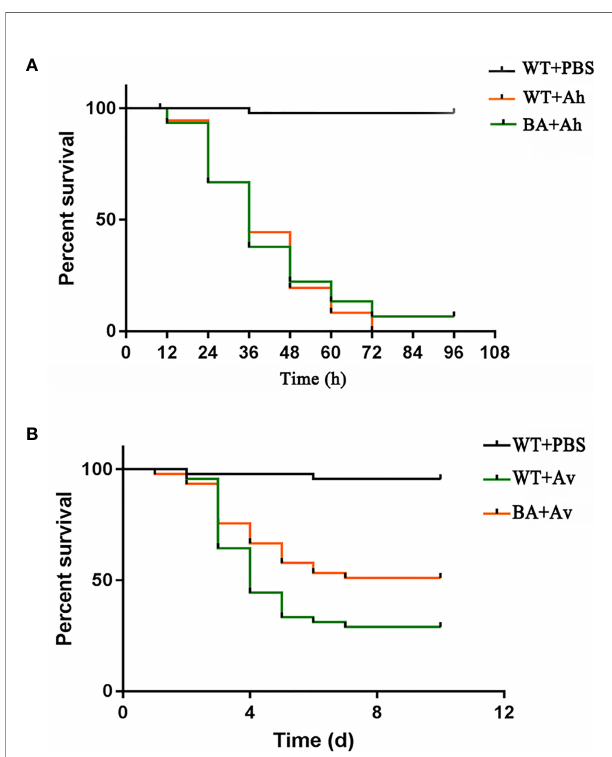
FIGURE 10 | The cumulative survival rate of grass carp in control group and experimental group. (A) The cumulative survival rate of grass carp after being infected with AhX040; (B) The cumulative survival rate of grass carp after being infected with